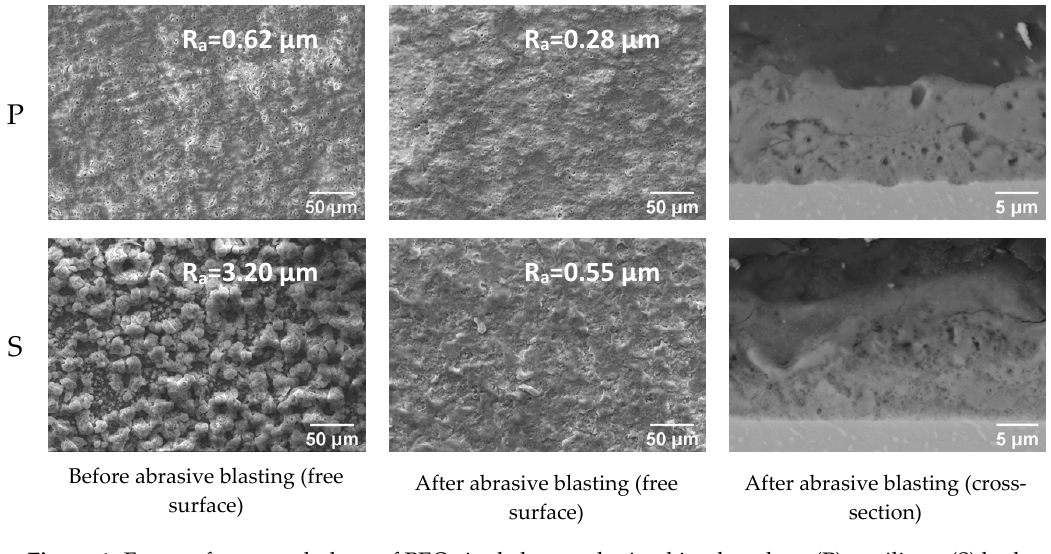
Figure 1. Free surface morphology of PEO single layers obtained in phosphate (P) or silicate (S) bath (DC mode), before (left) and after (centre) abrasive blasting (SE images). Cross-sections of the same layers after abrasive blasting (right, BSE images).